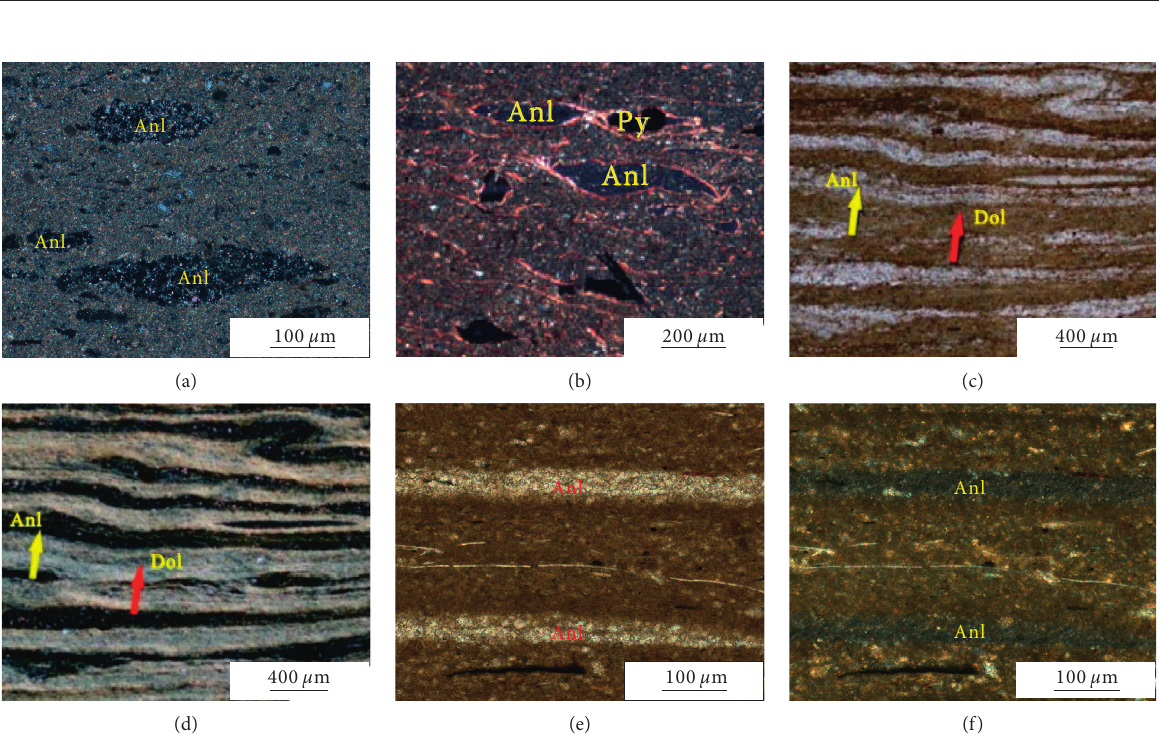
Figure 8: Analcime transformed from clay minerals. (a) Analcime aggregation is lenticular. (b) The interference color of the matrix is affected by dispersed calcite micrite and the entire matrix is dark [19]. (c, d) Microcrystalline analcime and microcrystalline dolomite are thinly interbedded [8]. (e, f) Microcrystalline analcime is interbedded with clay layers and mixed